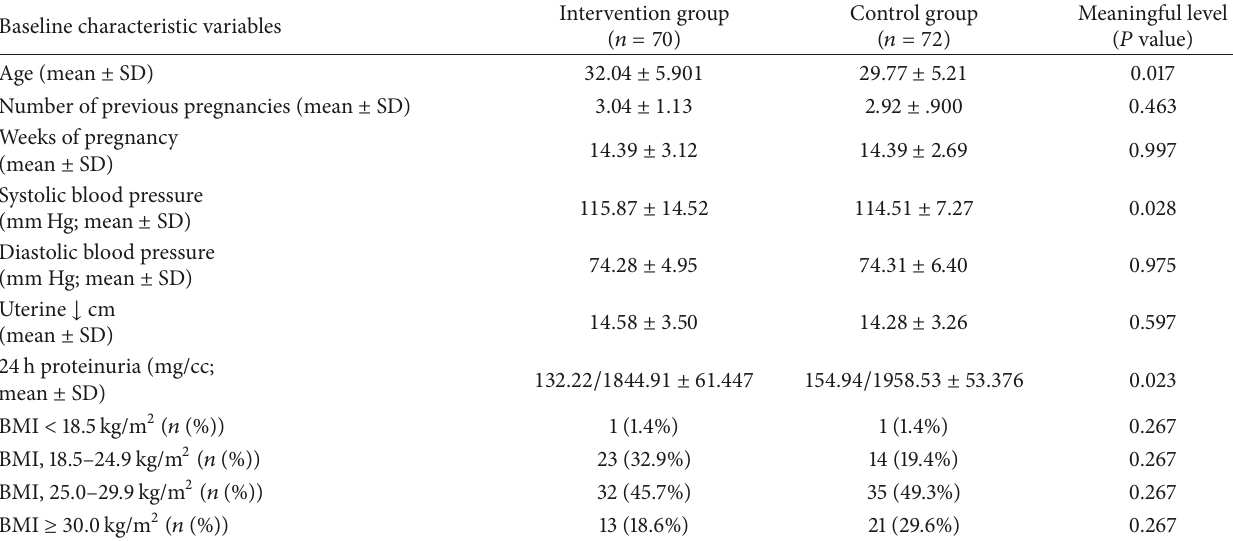
Table 1: Baseline characteristics of participants per group.